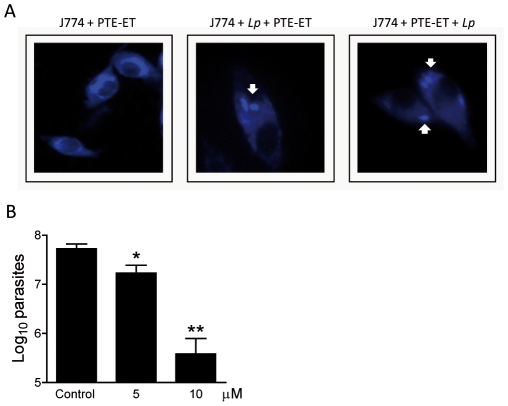
Antileishmanial activity of edelfosine against intracellular Leishmania amastigotes within macrophage-like J774 cells.(A) J774 cells, incubated with the blue-emitting fluorescent analog PTE-ET (left panel), or with L. panamensis (Lp) and then with PTE-ET (middle panel), or with PTE-ET and then with L. panamensis (Lp) (right panel), were analyzed by fluorescence microscopy to examine drug localization. White arrows point to the intracellular amastigotes. (B) Parasite burden in L. panamensis-infected J774 cells untreated (Control) and treated with 5 or 10 µM edelfosine for 24 h. Data are means ± SD or representative of four independent experiments. Asterisks indicate that the differences between control and edelfosine-treated groups are statistically significant. (*) P<0.05. (**) P<0.01.